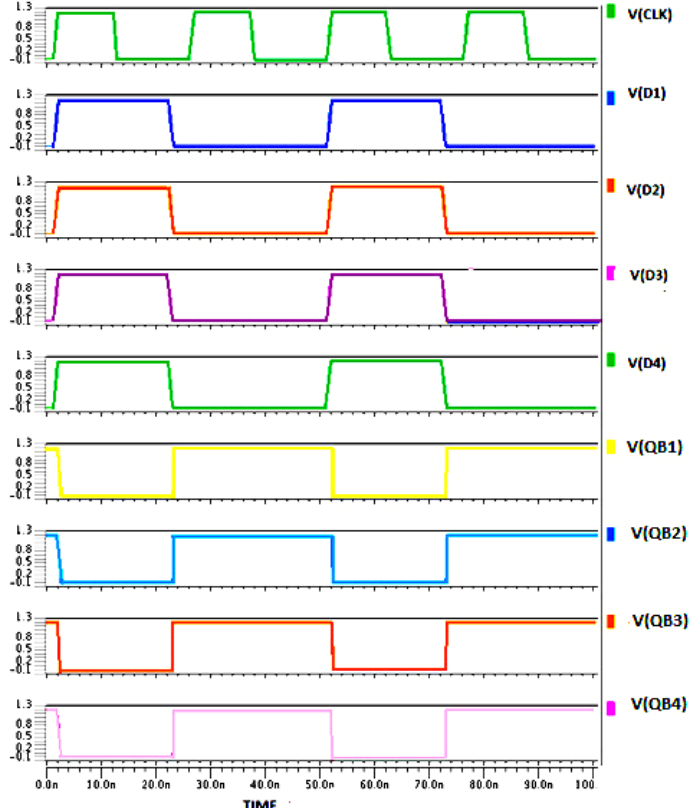
Figure 13. The simulation results of the PIPO shift register.